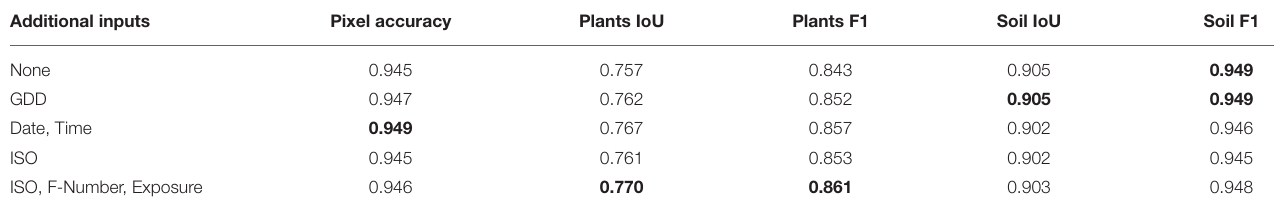
TABLE 5 | Feature injection influence when using different metadata.